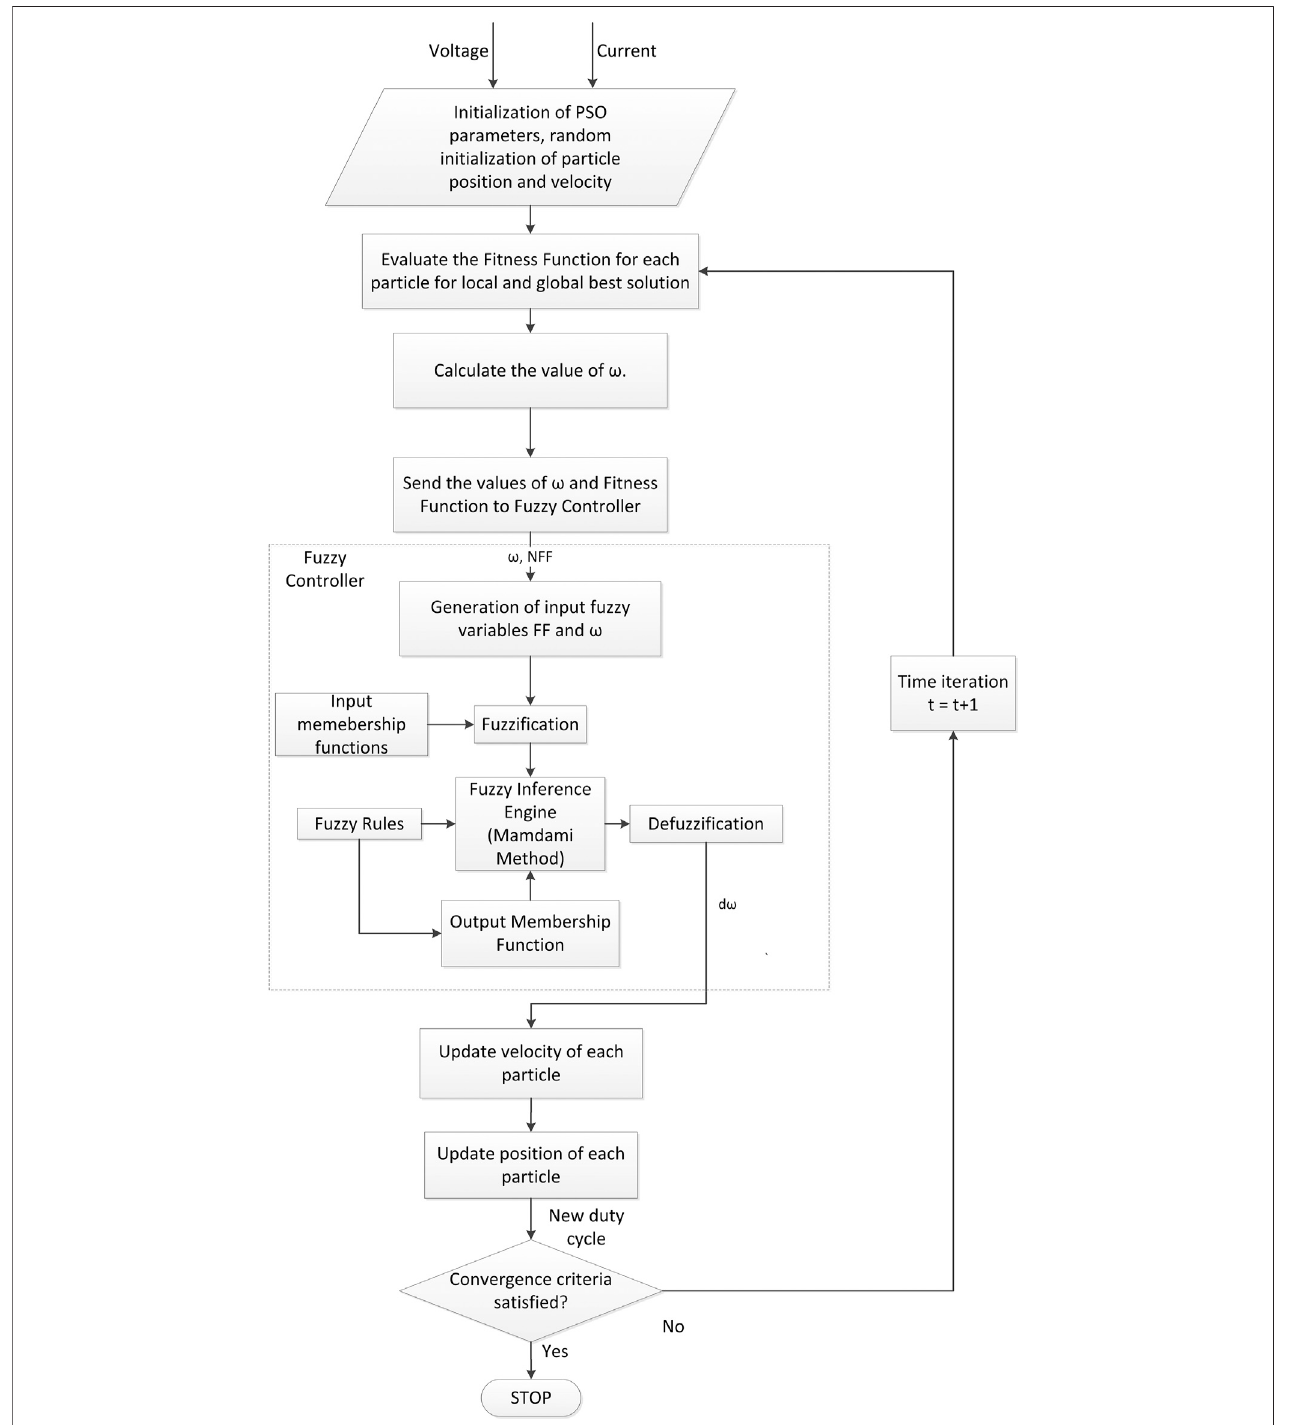
FIGURE 2 | Flowchart of the proposed fuzzy adaptive PSO controller.